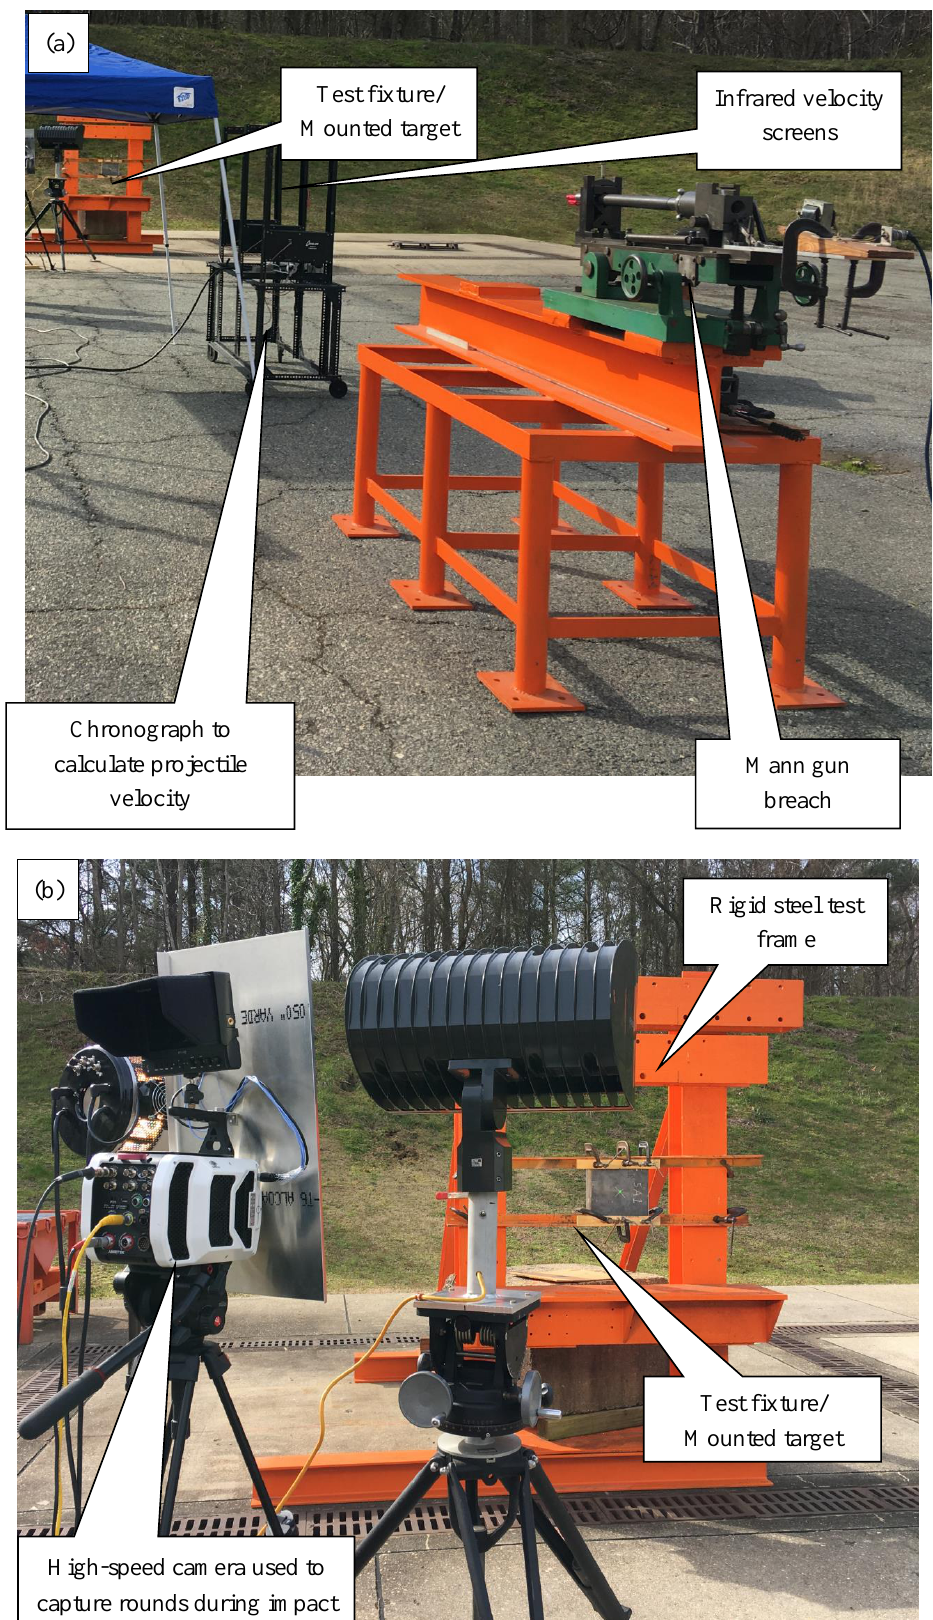
Figure 4. ( a ) Ballistic testing set up showing the arrangement of the target panel placed downrange from the Mann gun, used to fire the threat, as well as the velocity chronographs and high-speed camera used to track the impact; ( b ) a closeup of the target fixture, rigid steel frame and the high-speed camera to capture the rounds at the point of impact.